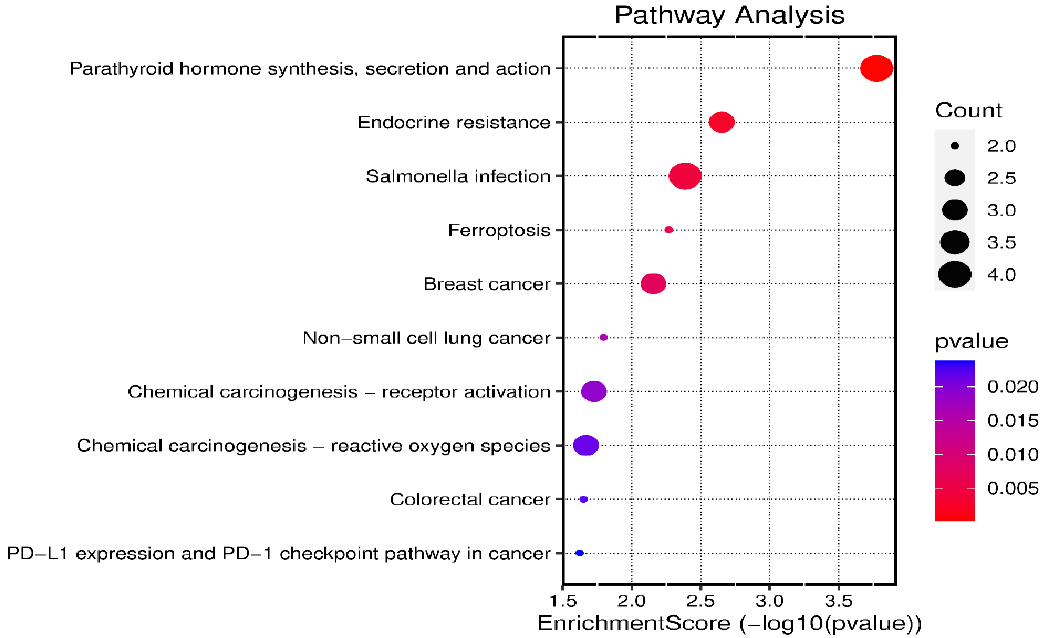
Figure 7. Bubble chart of GO enrichment analysis of differently expressed genes. The size of bubble represents the counts of DGEs, and the different colors represent the significance of the difference ( p value).